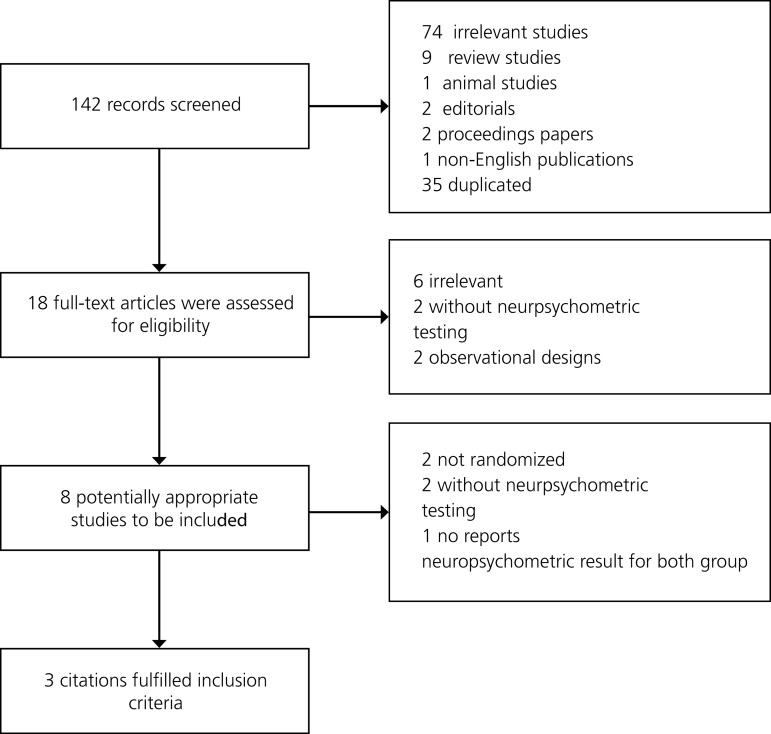
Flow diagram of the selection process for eligible articles.